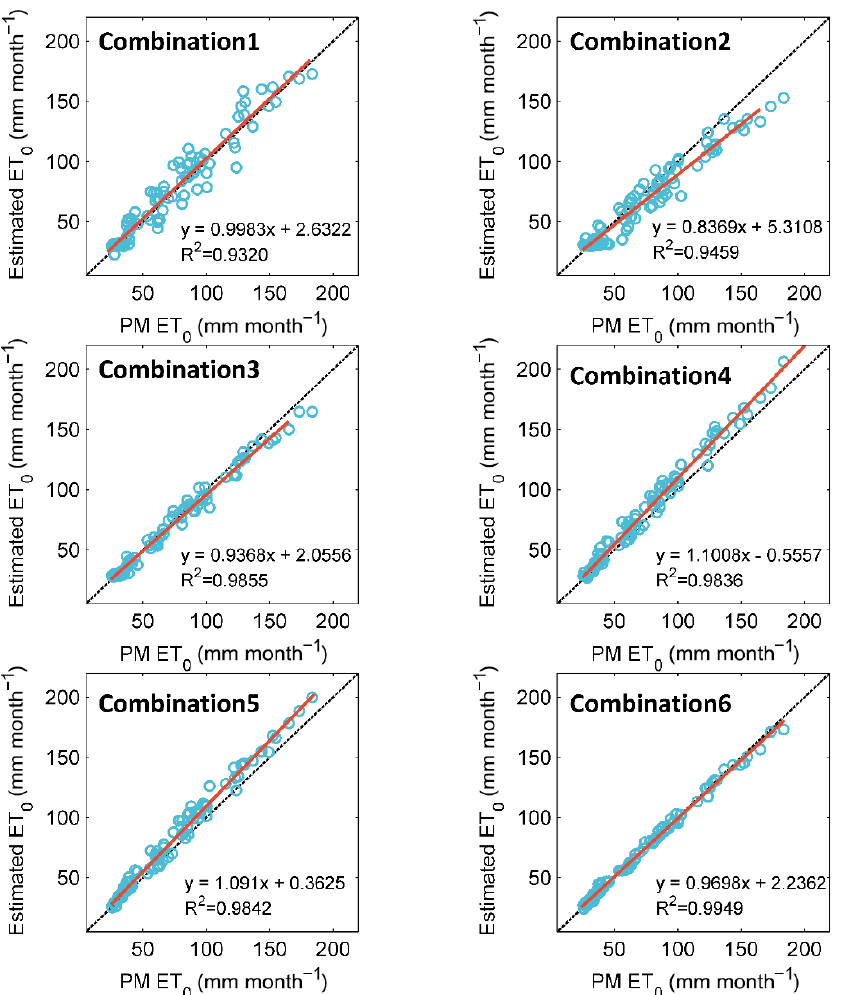
Figure 6. Scatter plots of ET 0 values estimated by the C-ELM model against FAO-56 PM ET 0 values at Shapinba station during the testing period.